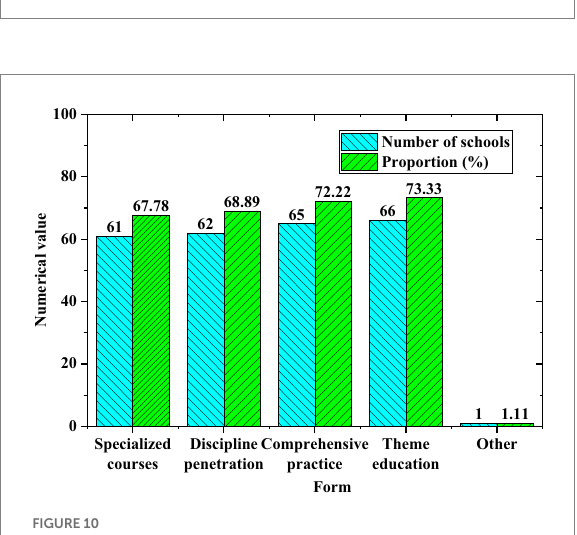
FIGURE 9 The way teachers improve their professional level.